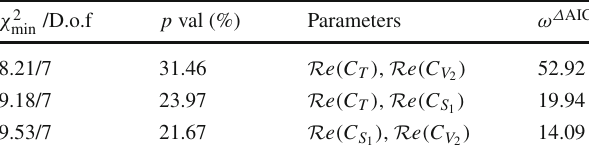
Table 11 Scenarios selected after passing the criterion Δ AIC c ≤ 4 for the analysis considering the errors of R D (from BABAR), R D ∗ (from BABAR) and P τ ( D ∗ ) (from Belle) one order lesser than the quoted one (more precise), along with all the other data available (without R J /ψ ) χ 2 /D.o.f min